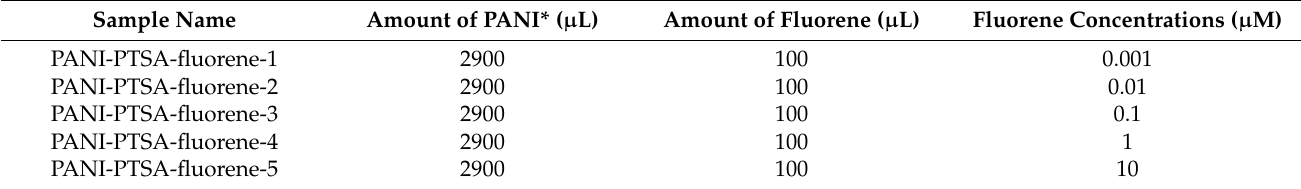
Table 2. Preparation of PANI-PTSA with fluorene